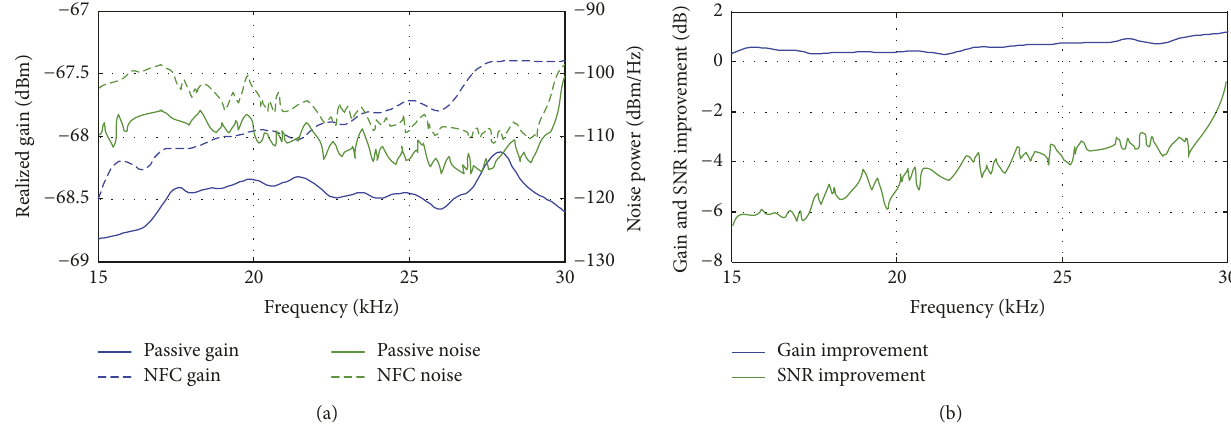
Figure 13: Measurement setup to record (a) gain, noise of passive, and non-Foster matching network and (b) gain, SNR improvement of passive, and non-Foster matching